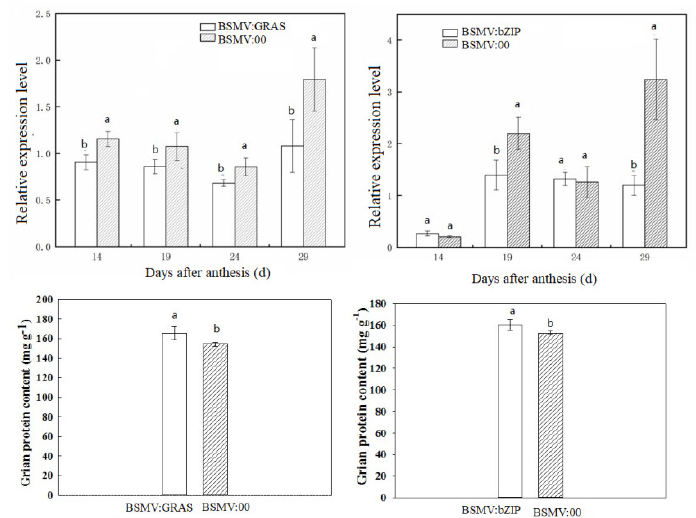
Figure 4. Gene functional analysis by BSMV-VIGS. BSMV-VIGS, barley stripe mosaic virus-based virus-induced gene silencing system; BSMV:00 indicate empty vector; BSMV:bZIP and BSMV:GRAS indicate that silencing bZIP and GRAS gene, respectively; Different lowercase letters above the column on the same day indicate a significant difference ( p < 0.05).